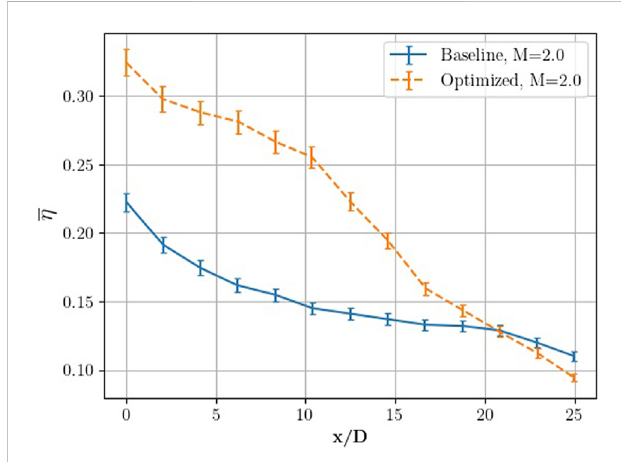
FIGURE 14 Laterally averaged fi lm cooling effectiveness distribution pro fi le with the blowing ratio set to M =